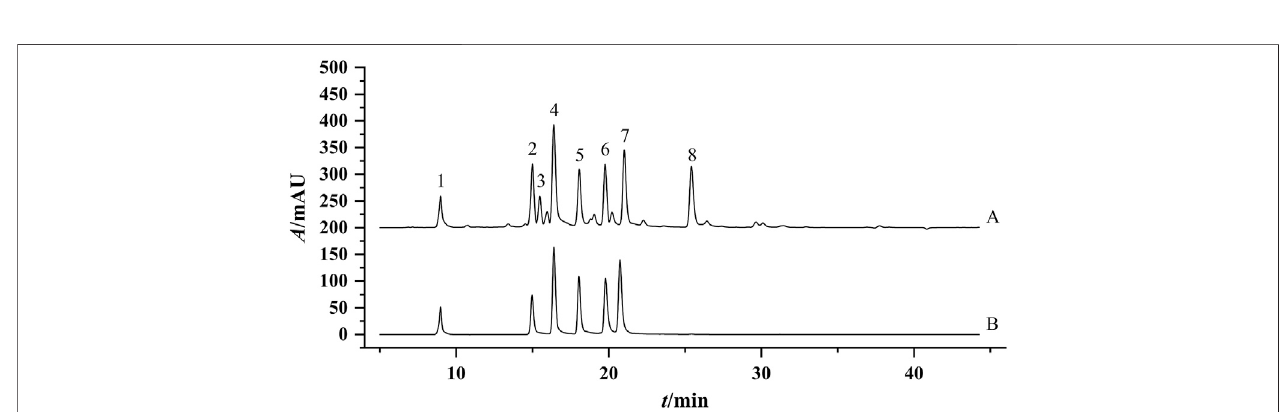
FIGURE 4| Representative chromatogram ofthe Sample JH-07 (A) and mixed standard solution (B) . 1: ChA; Peak 2, 3,5-DCQA; Peak 3, Unknown peak 1; Peak 4, L-7G; Peak 5, 4.5-DCQA; Peak 6, A-7G; Peak 7, K-3R; Peak 8, Unknown peak 2.